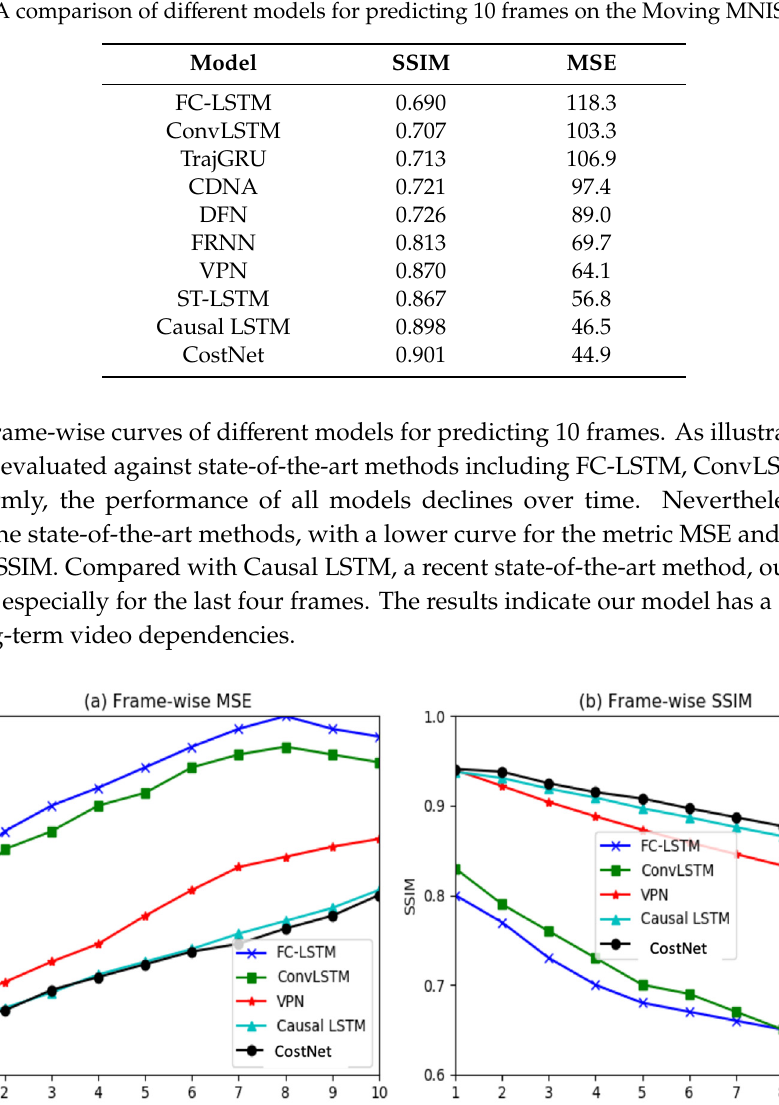
Figure 4. Prediction examples on the Moving MNIST test. 5.2. Radar Echo Dataset 5.2.1. Implementation